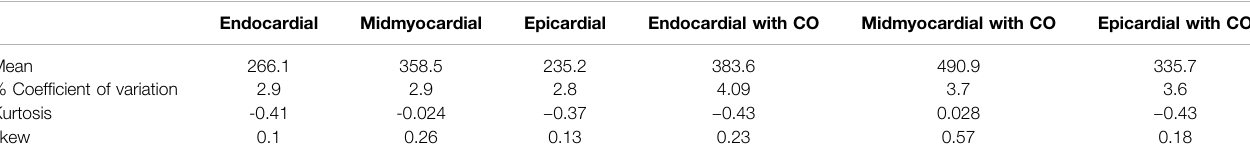
TABLE 3 | CO increases variability: statistical moments of APD 90 probability density estimates of Figure 8 . Endocardial Midmyocardial